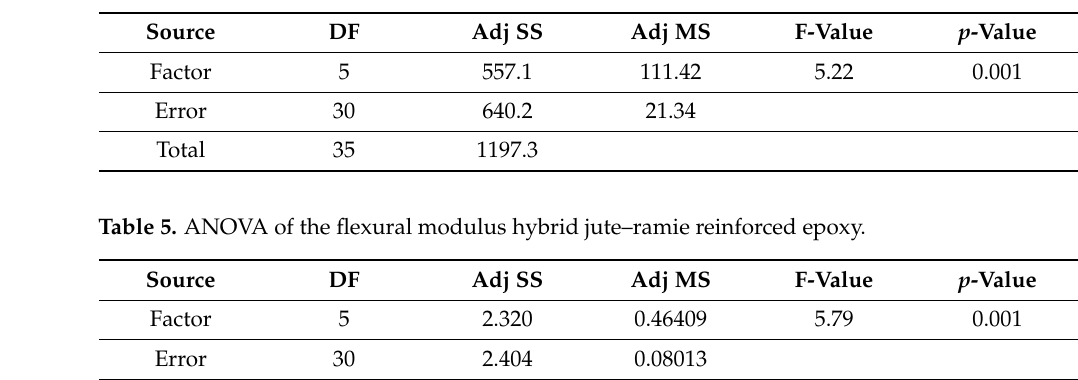
Table 4. ANOVA of the flexural strength hybrid jute–ramie reinforced epoxy.